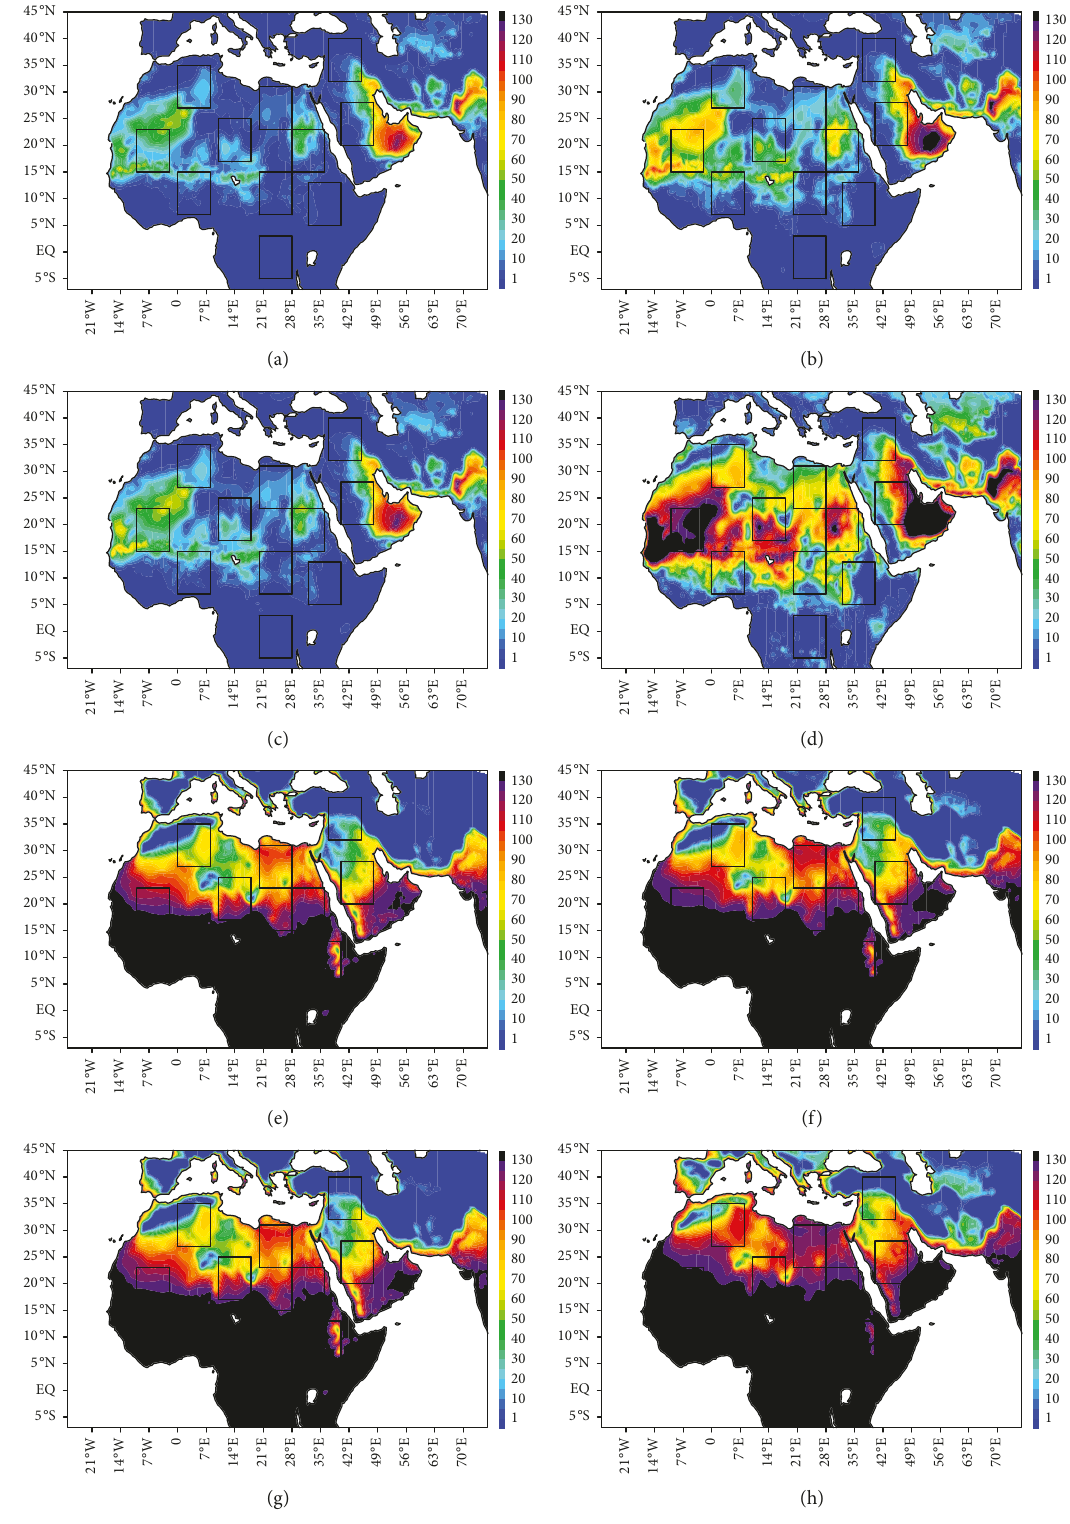
Figure 7: Spatial distribution of RegCM4-simulated hot days ( T ° C) for (a) RCP4.5 near future, (b) RCP4.5 far future, (c) RCP8.5 max > 50 near future, and (d) RCP8.5 far future along with cold nights ( T min < 5 ° C) for (e) RCP4.5 near future, (f) RCP4.5 far future, (g) RCP8.5 near future, and (h) RCP8.5 far future. Average is taken over HadGEM2- and ECHAM6-driven runs. The near and future is 2021–2050 and 2071–2100,